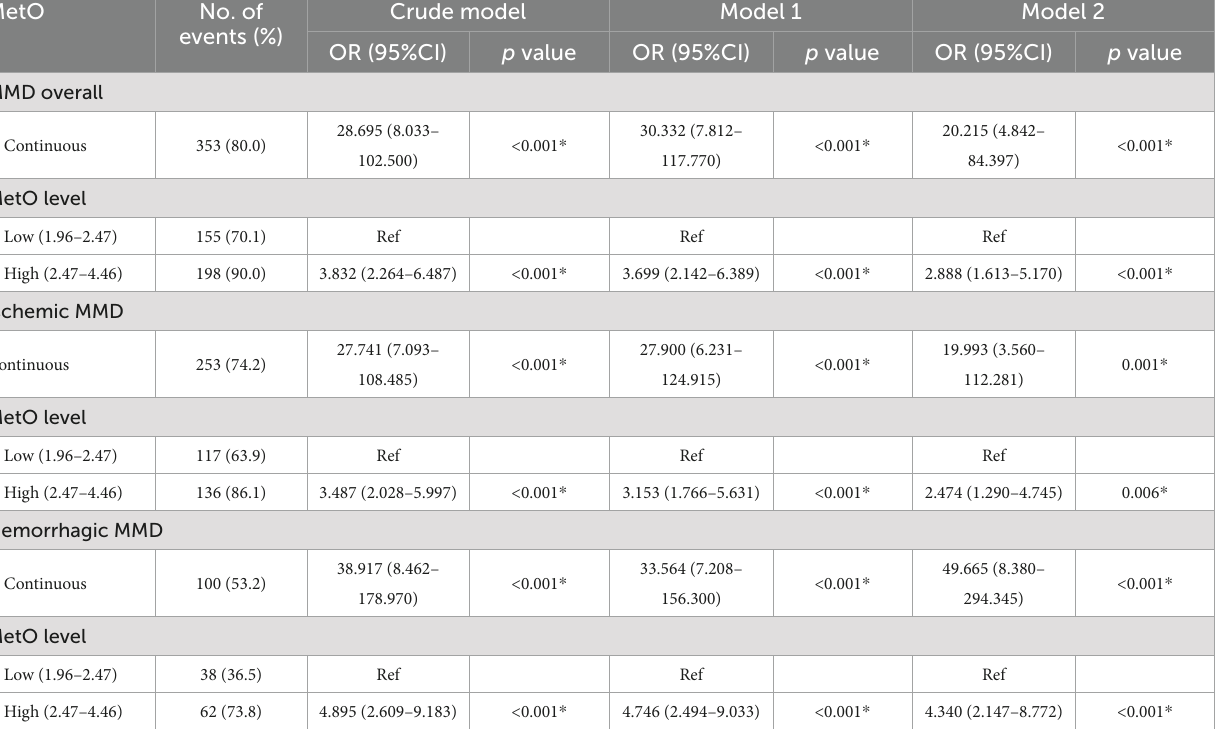
TABLE 5 Association between different MetO levels and the risk of MMD and its subtypes. MetO No. of events